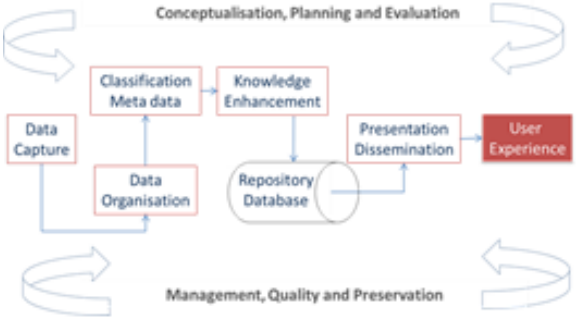
Figure 9: System Architecture for Archival and Storage Repository